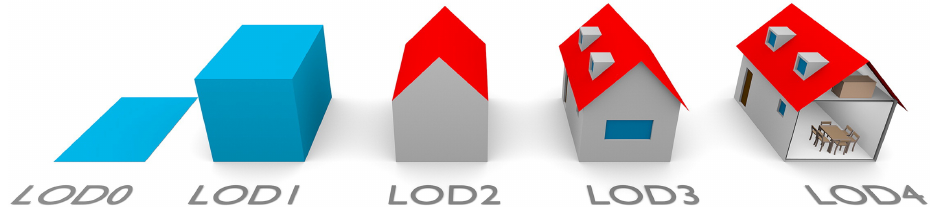
Figure 2. Visualization of LOD0 to LOD4 in the CityGML format